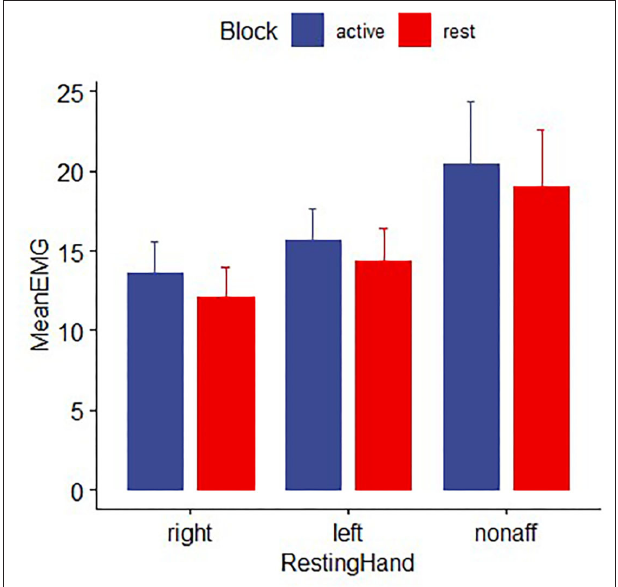
FIGURE 6 | EMG activity for healthy controls and patients with stroke for the non-performing hand during time periods while the other hand was moving the joystick for the pointing task (active block) or resting (rest block). EMG in the nonperforming hand did not differ significantly between movement and rest blocks, indicating the absence of mirror movements. Error bars reflect